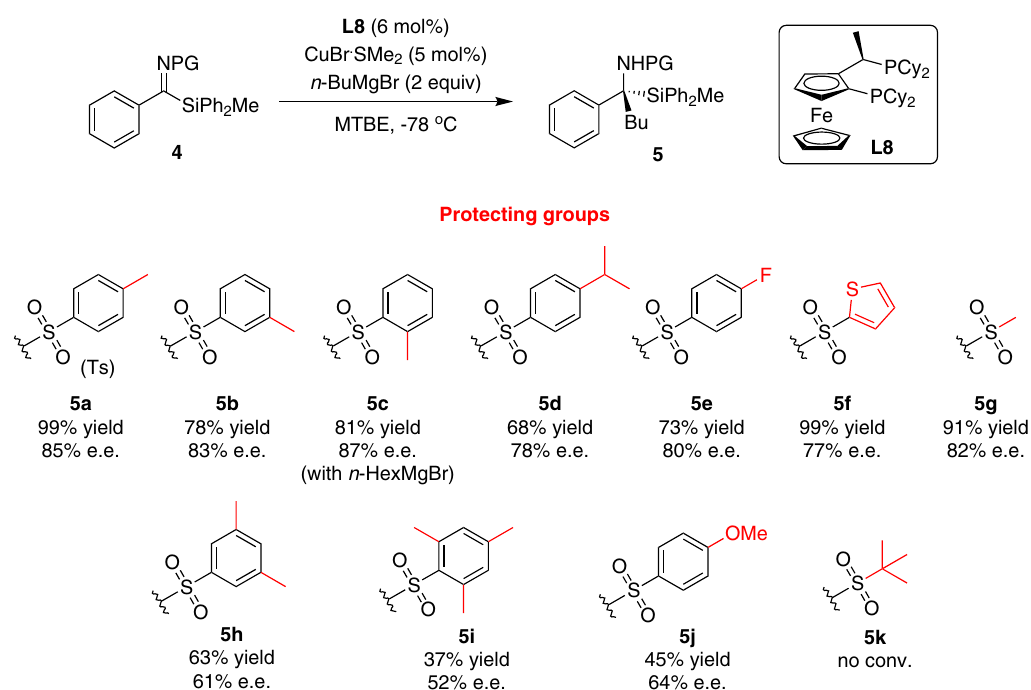
Figure 1 | Effect of the sulfonyl-protecting group. Evaluation of sulfonyl-protecting group on the reactivity of the ketimines and the enantioselectivity of the addition